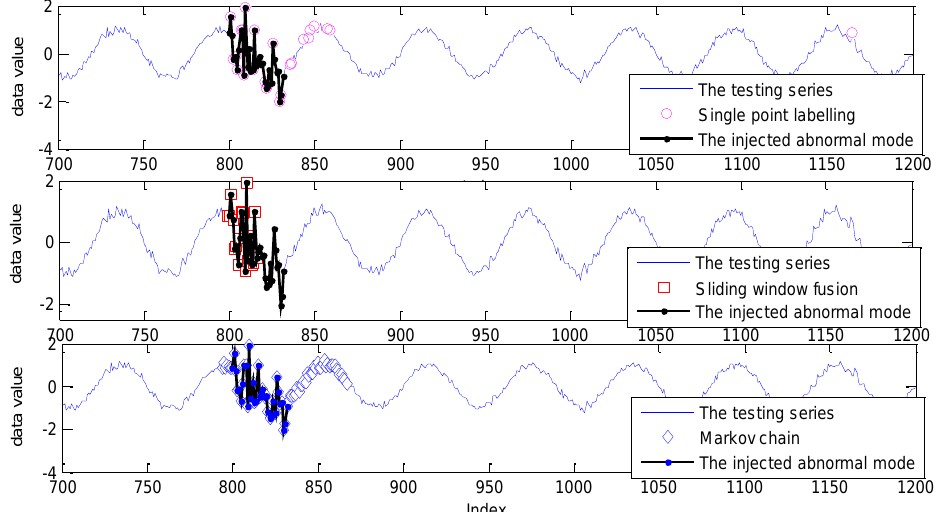
Figure 11. The detection results for the Ma Data based on the GPR model with three labelling strategies under the sliding window size of 10.